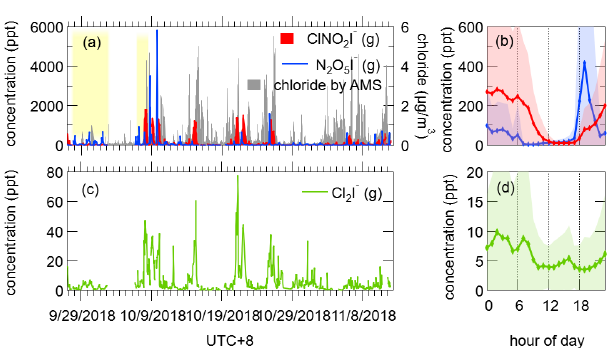
Figure 10. Time series and diurnal variations of humidity-corrected concentrations of N 2 O 5 and ClNO 2 (a, b) and Cl 2 (c, d) . The tinted background indicates the days with high concentrations of N 2 O 5 but low concentrations of ClNO 2 . The shaded areas indicate 1 stan- dard deviation.